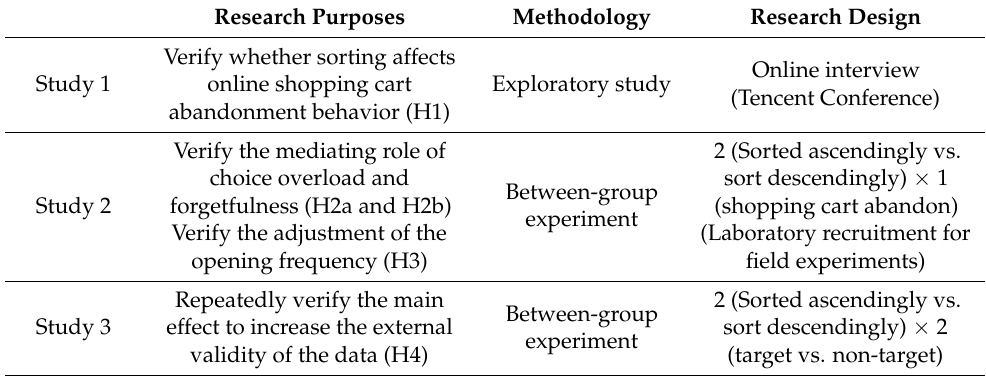
Table 2. Research